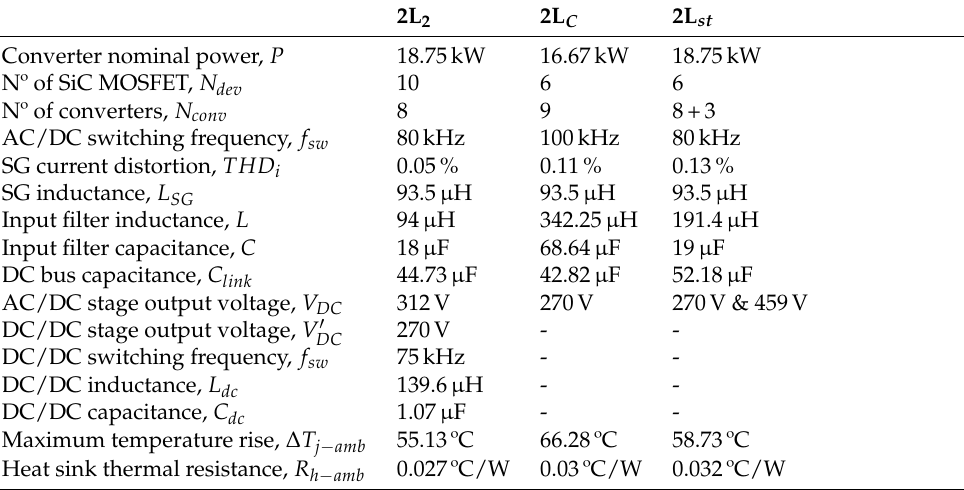
Figure 10. DM input filter results of 2L 2 architecture for fulfilling LF and HF requirements. Table 3. Summary of the design parameters of 2L 2 , 2L C , and, 2L st